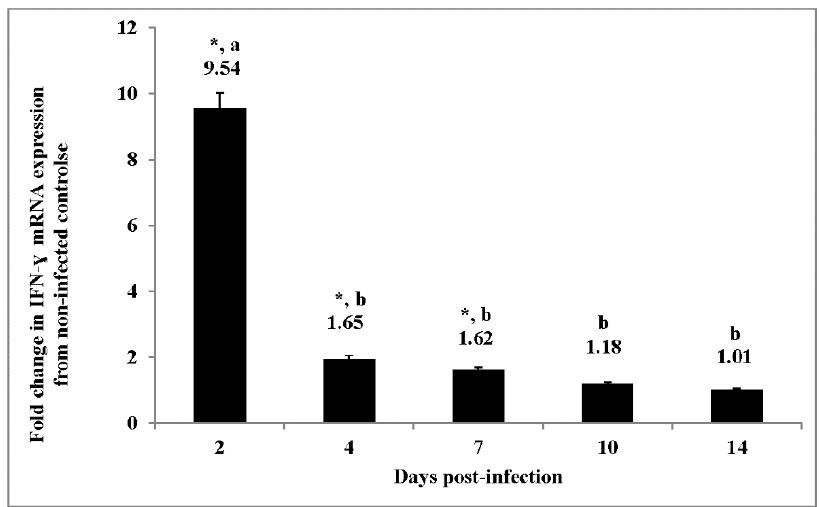
Figure 1. Expression of IFN- γ mRNA in the ceca from experimental chickens with persistent colonization by Salmonella Enteritidis. The expression of IFN- γ mRNA expression was determined by quantitative RT-PCR. Data represent the fold-change in mRNA expression in the cecum from infected chickens when compared to the mRNA expression in the cecum from non-infected chickens. Data represent the mean ± SEM from three separate experiments. * = significantly different from the non-infected controls. Different lower case letters = significantly different from infected chickens at 2 days post-infection ( p ± 0.05).